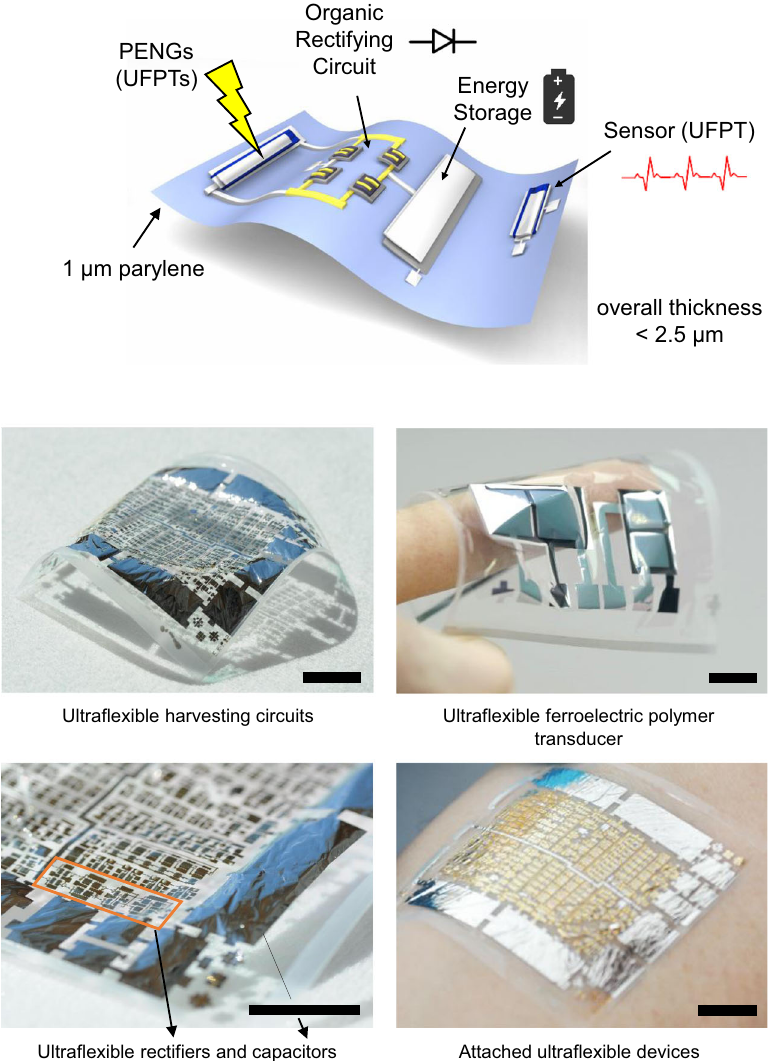
Fig. 1 Ultra fl exible piezoelectric energy harvesting and sensing. Scheme of a range of ultra fl exible devices integrated on a 1- µ m thin parylene substrate and photographs of the fabricated devices. Ultra fl exible ferroelectric polymer transducers (UFPTs) are used for vital parameter sensing and as piezoelectric nanogenerators (PENGs) for harvesting biomechanical energy when attached to the skin. For the comprehensive ultra fl exible energy-harvesting device (UEHD), the ultra fl exible nanogenerators are combined with ultra fl exible circuits comprising organic diodes as recti fi ers and thin- fi lm capacitors for energy storage. Scale bar, 1